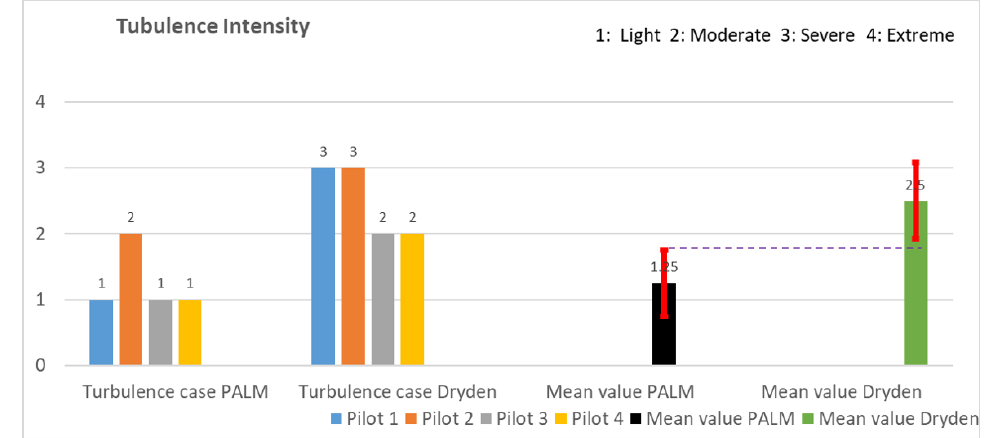
Figure A3. Turbulence